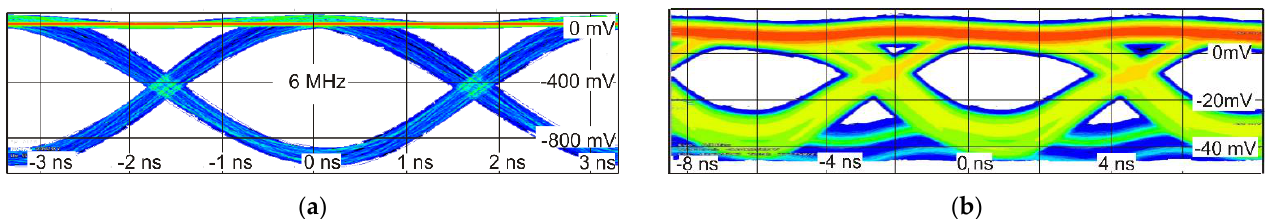
Figure 13. View of the eye diagrams for FSO setup with ( a ) pulsed and ( b ) cw lasers.